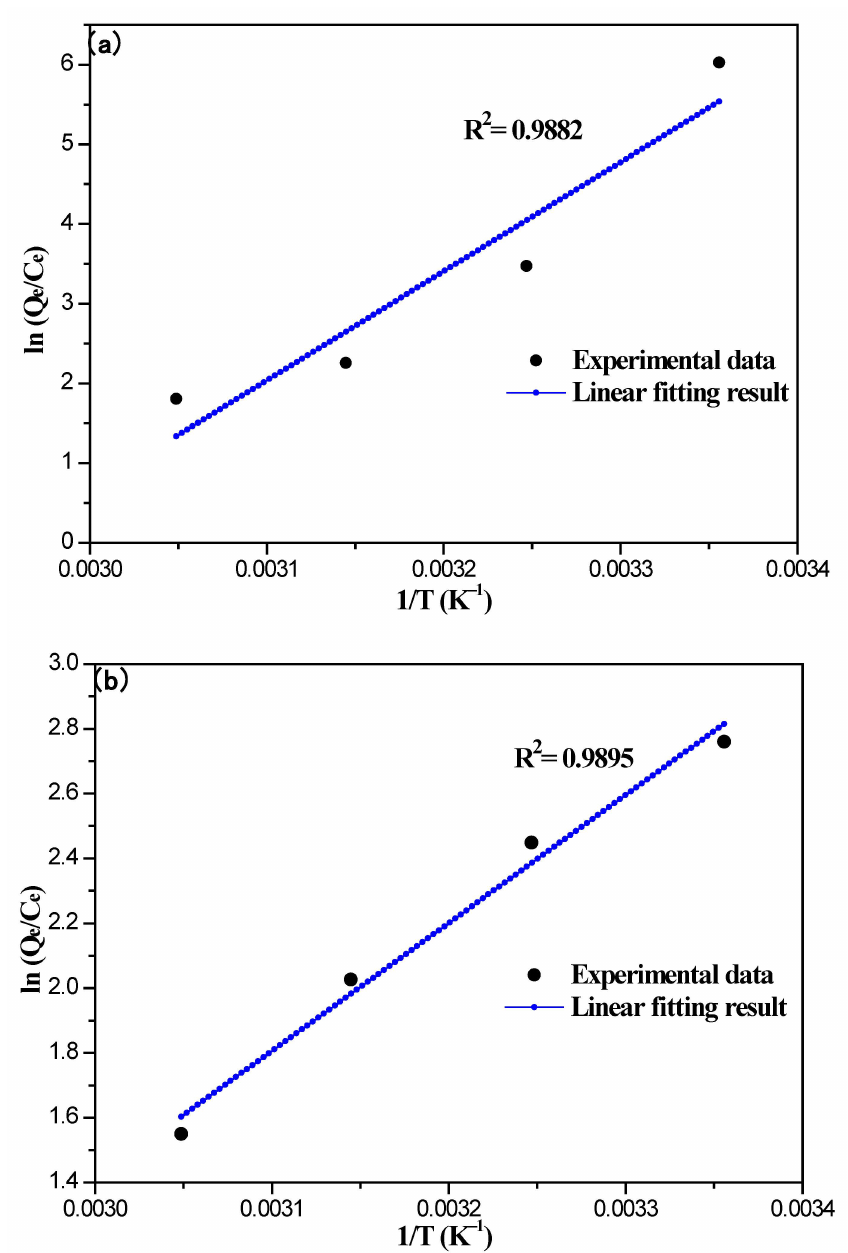
Figure 13. The plot dependence of ln(Q e /C e ) on 1/T: (a) 8%Fe 3 O 4 @MMC and (b) 8%Fe 3 O 4 @MAC. Adsorption conditions: the initial Cr(VI) ions’ concentration, 80 mg · L − 1 ; volume, 50 mL; pH, 2.0; adsorbent dosage, 0.03 g; adsorption time, 180